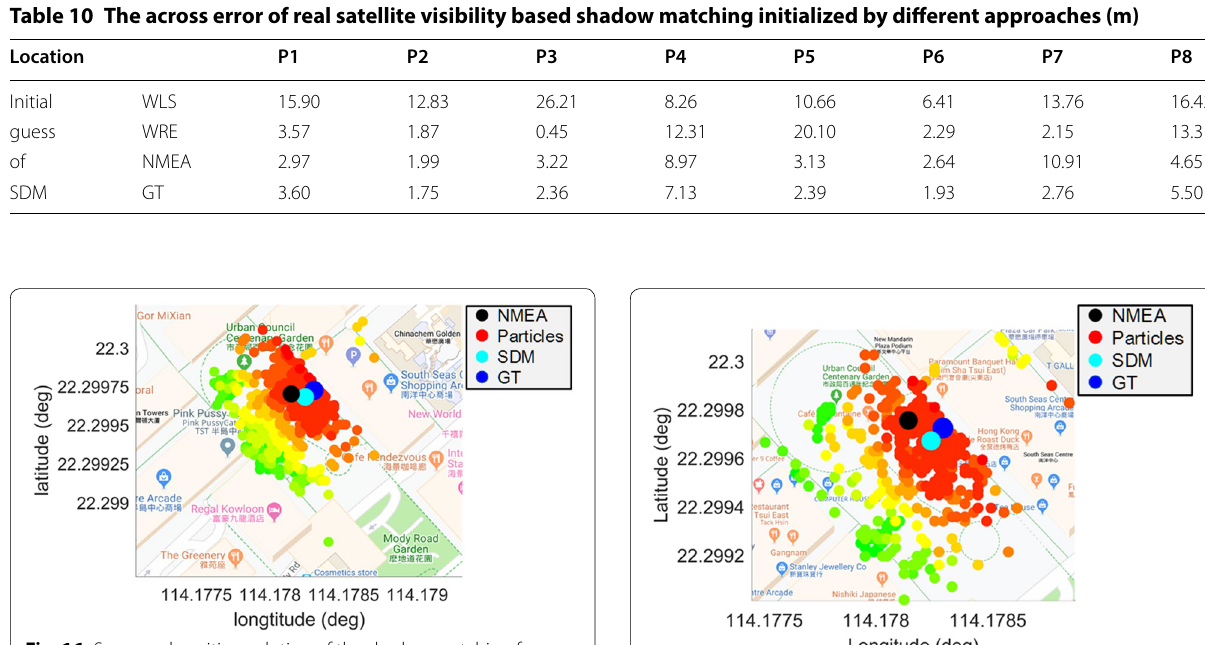
Fig. 16 Score and position solution of the shadow matching from SDM‑NMEA initialization at P2 Fig. 17 Score and position solution of the shadow matching from SDM‑WRE initialization at